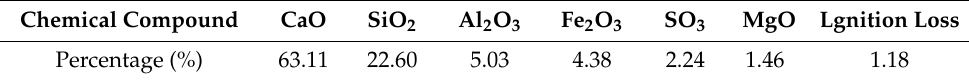
Table 2. Chemical composition of P.O42.5 grade ordinary Portland cement.